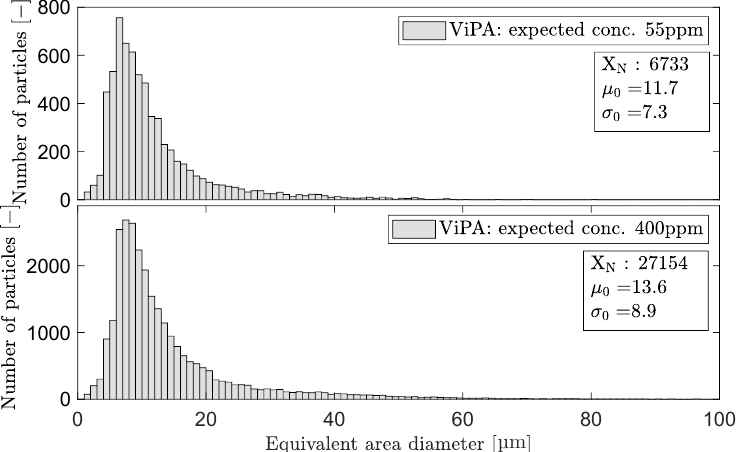
Figure 14. Droplet size distribution obtained with C 2 based on the measured OiW concentrations at the known concentration of 55 ppm and 400 ppm,